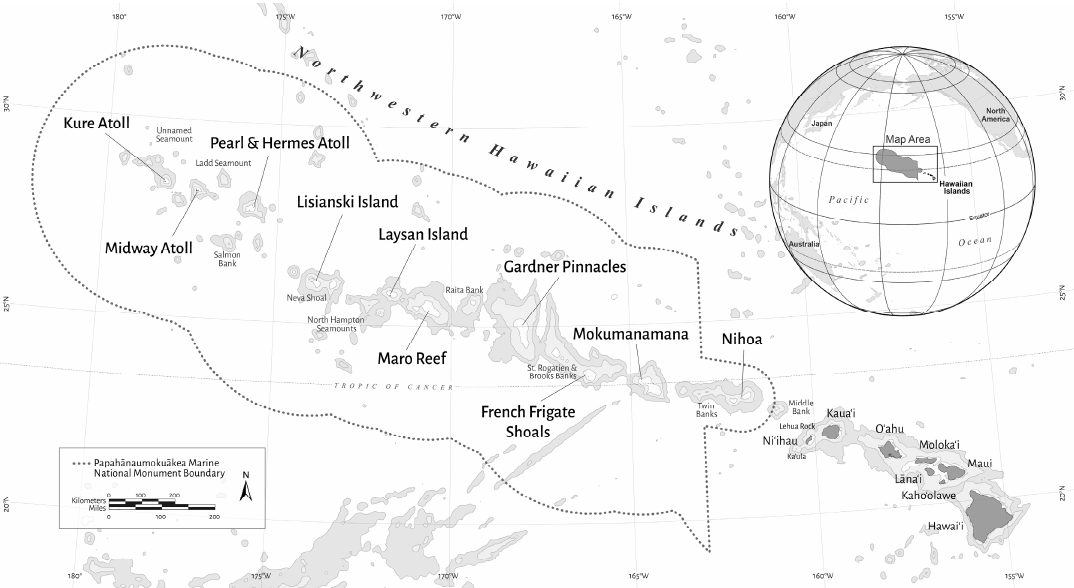
Figure 1. Map of the Hawaiian Archipelago, including the Northwestern Hawaiian Islands (NWHI). The boundary of Papah ā naumoku ā kea Marine National Monument is shown by the dotted line.